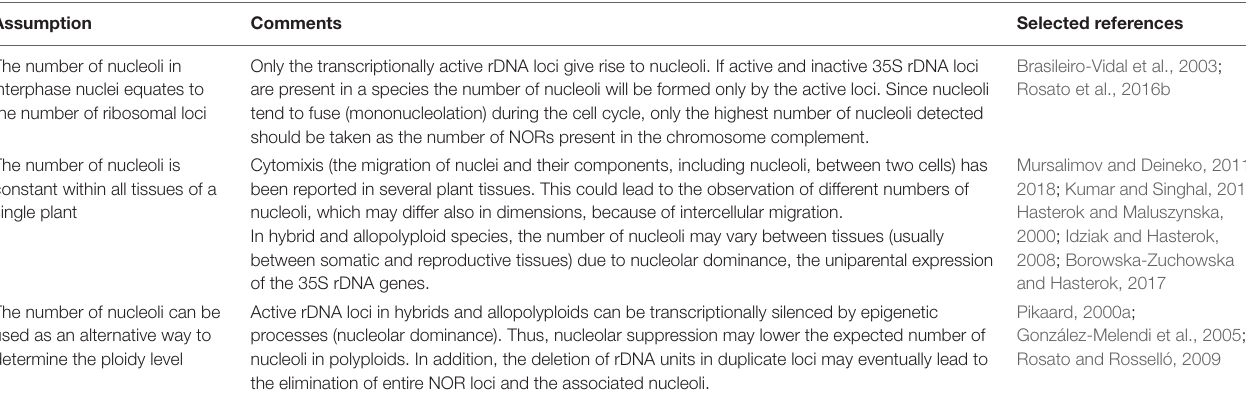
TABLE 4 | Intra- and interindividual variation in nucleoli number: assumptions about their use in plant evolution.